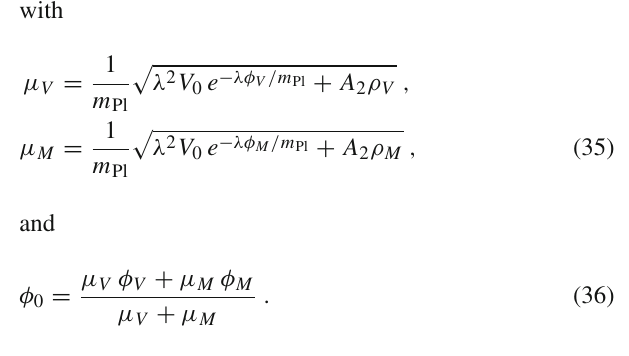
A prototype solution with values A 2 = 10 35 , λ = 10 25 and V 0 = 1 . 00034 × 3 (cid:9) (cid:10) 0 m 2